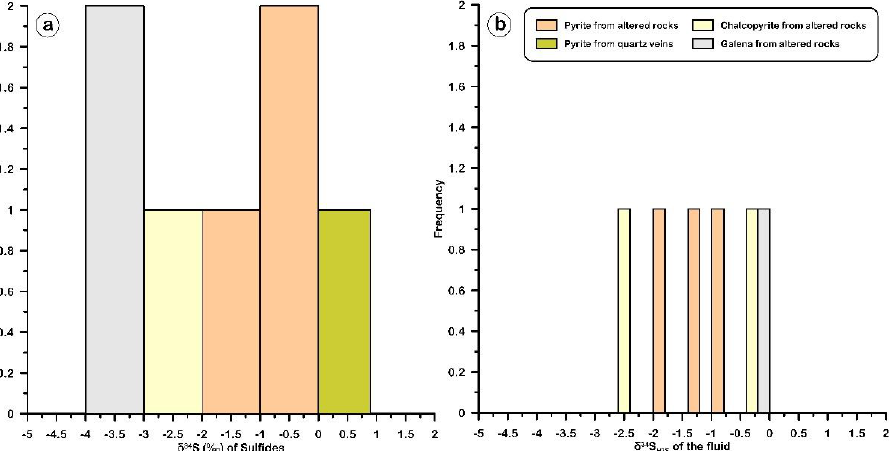
Figure 15. Histograms of ( a ) the δ 34 S isotopic compositions for sulfide minerals (pyrite, chalcopyrite, and galena) and ( b ) the δ 34 S H2S of the fluid that formed the sulfides in the Halılar area. Table 4. Sulfur isotope values of sulfides from the Halılar area .